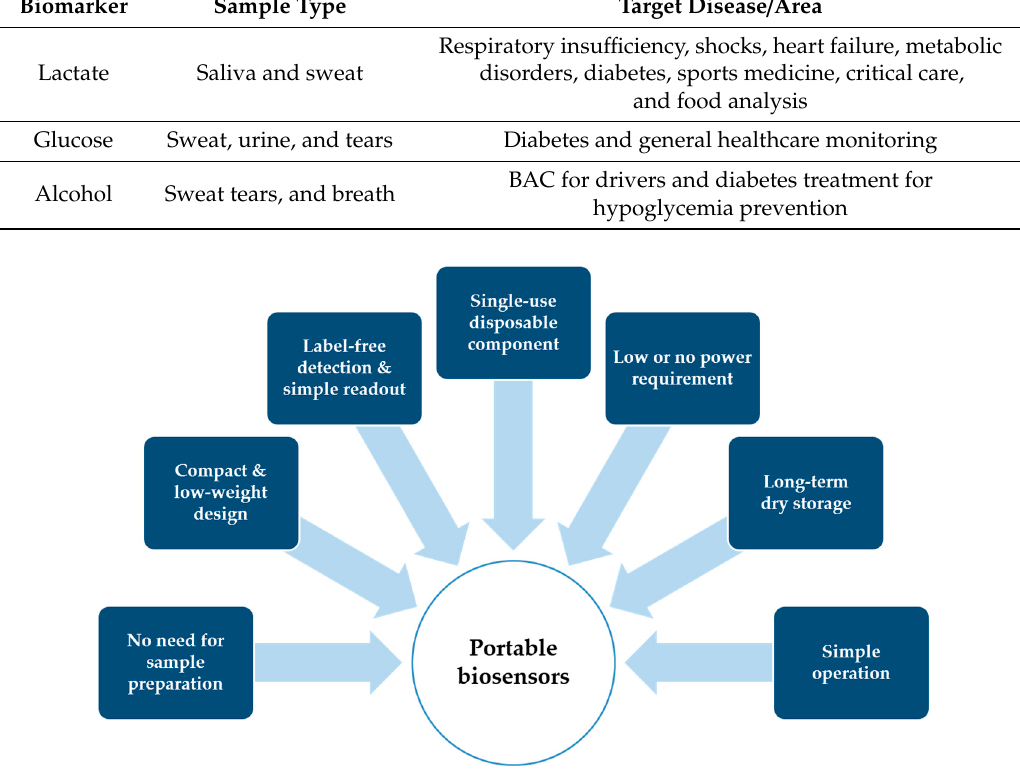
Figure 7. Key requirements for portable biosensors.